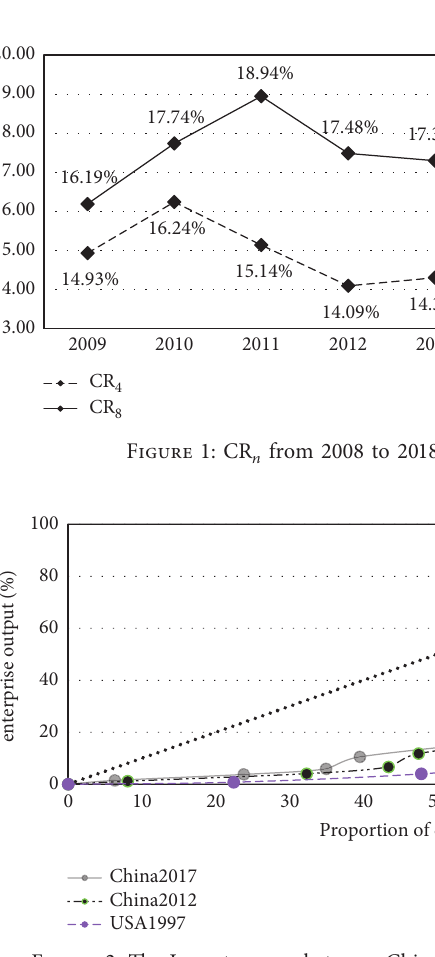
Figure 2: The Lorentz curve between China and the US construction industry.